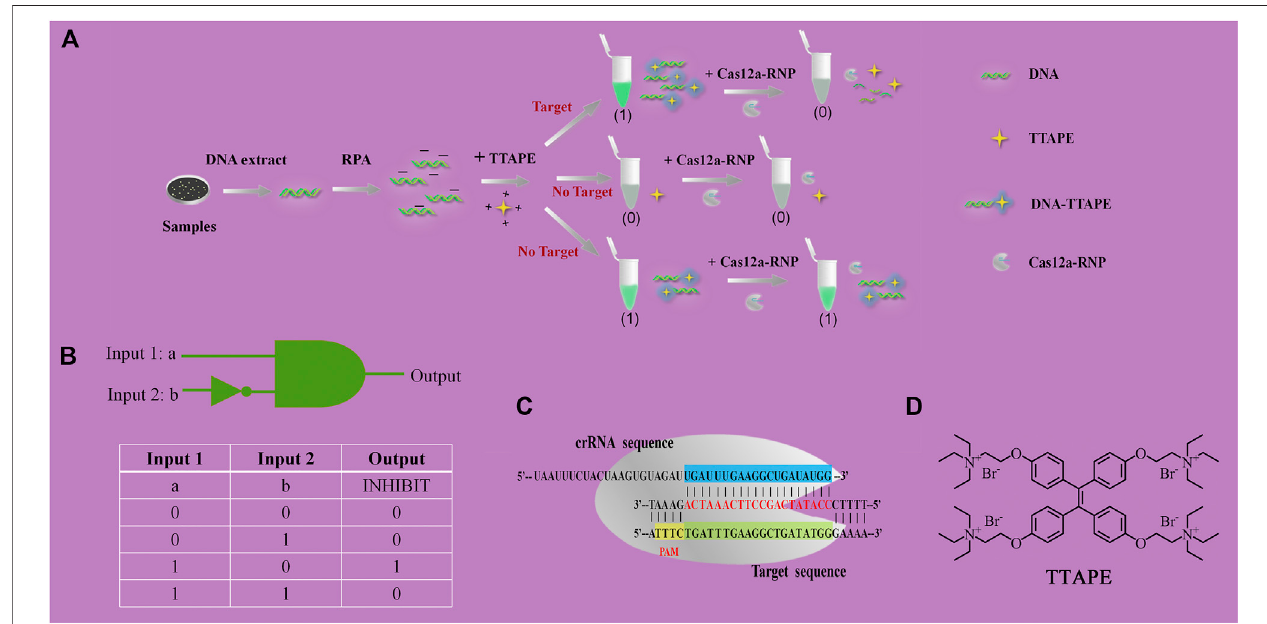
FIGURE 1 | (A) Schematic diagram of TTAPE-CRISPR/Cas12a platform for detecting pathogenic microorganisms; (B) Logical gate schematic diagram and real table value; (C) The process of CRISPR/Cas12a to recognize speci fi c DNA fragments of L. pneumophila ; (D) Chemical structure of TTAPE.